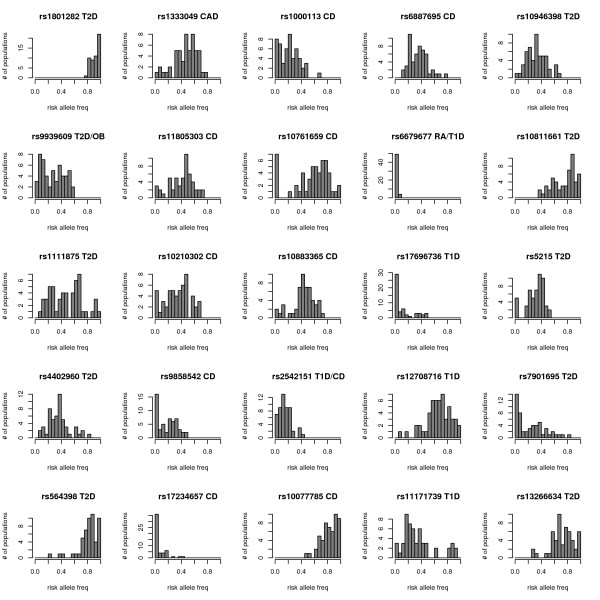
Risk allele frequency across populations for 25 disease-associated SNPs. The title of each histogram includes the dbSNP ID and the disease with which each SNP is associated. Abbreviations for disease names can be found in Table 1. Note that the Y axes have different scales across histograms.